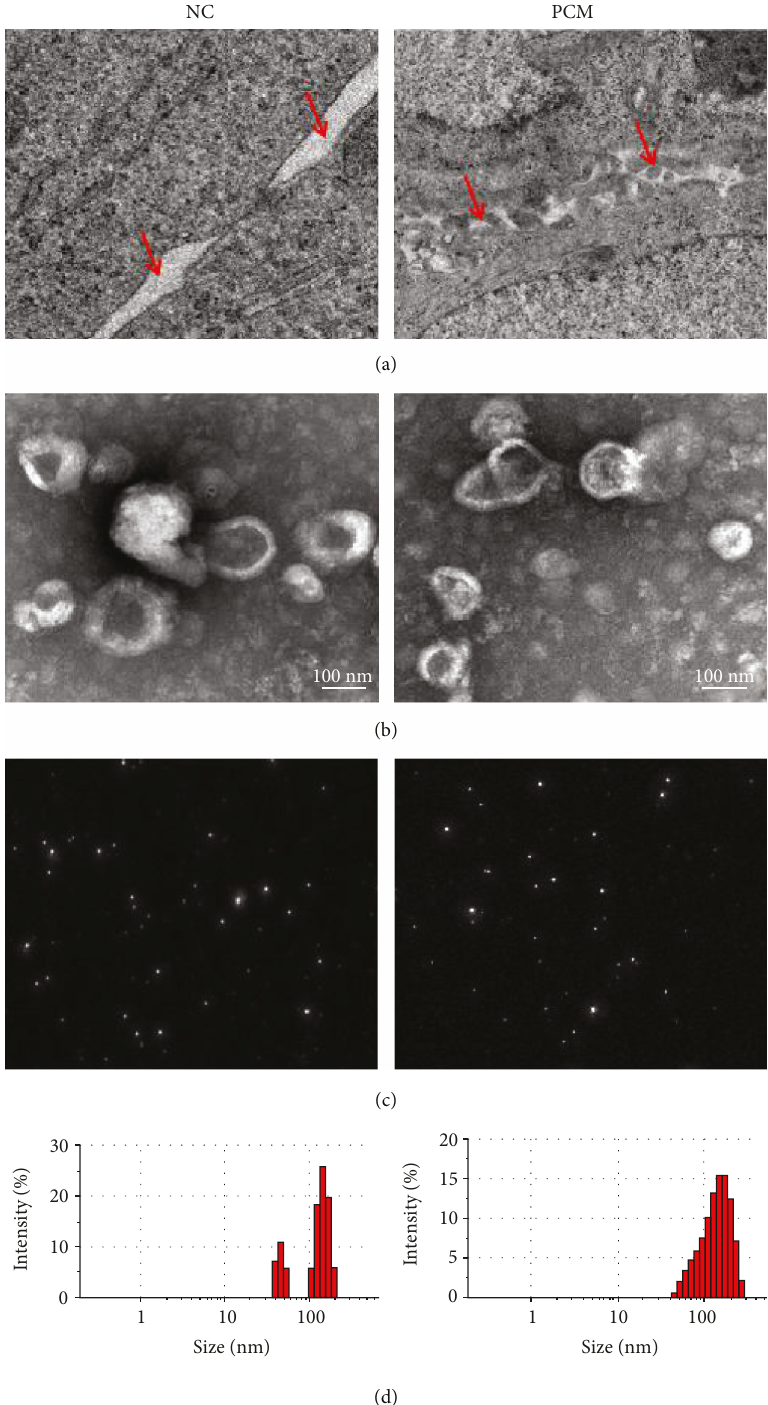
Figure 1: The ultrastructure changes of PCM and exosomes extracted from normal and PCM tissues were observed by a transmission electron microscope. (a) More microvesicles were found in the synaptic cleft of PCM indicated with red arrows. (b) A representative transmission electron microscopy image of PCM/exo and N/exo, showing a typical “ saucer-like ” morphology (scale bar, 100 nm). (c, d) Analysis of exosome size indicated similar particle size distribution of PCM/exo and